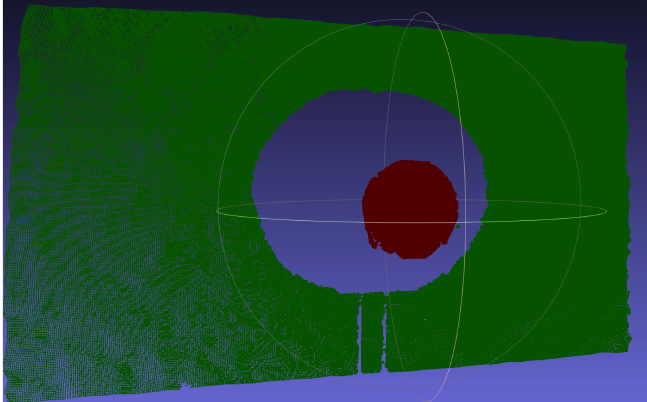
Figure 7. Visualization of experiment 1 in Meshlab.